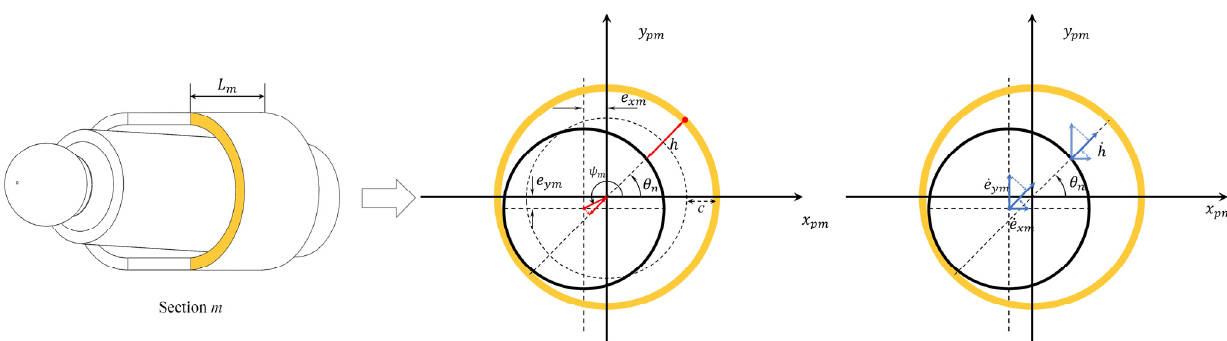
Figure 2. The piston eccentricity and radial movement of the section m. The film height is small compared with the dimension of the piston, so the curvature of the film can be neglected. The film can be transformed into a rectangular coordinate system, as shown in Figure 3. The gray surface denotes the piston surface, and the yellow one denotes the bushing surface.